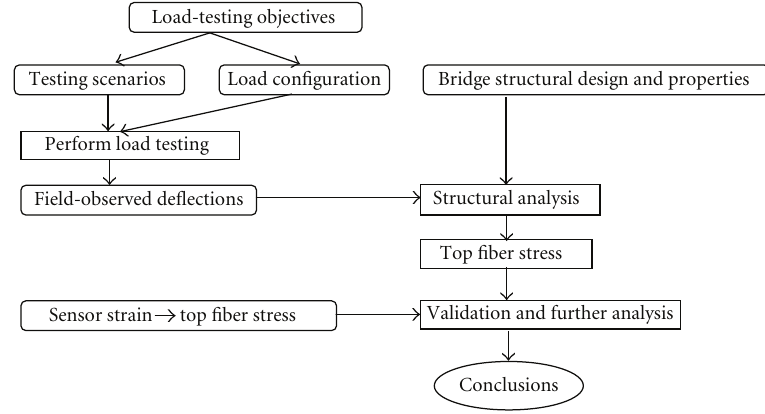
Figure 3: Flow chart of the bridge load testing.